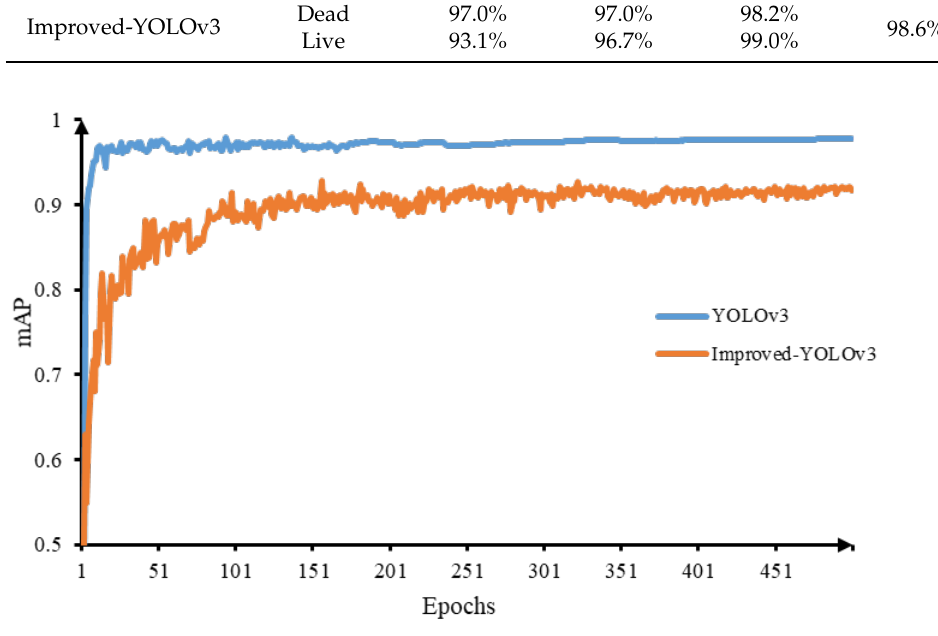
Figure 7. Training mAP of the improved-YOLOv3 and YOLOv3 models.